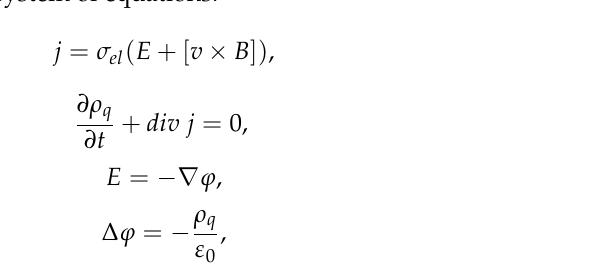
Table 2. Cumulative results of a series of numerical simulations at different levels of the magnetic flux density 𝐵 (cid:3053) = 0, 0.1, 1 and 10 T. The temperature and flow characteristics are averaged in the molten pool.